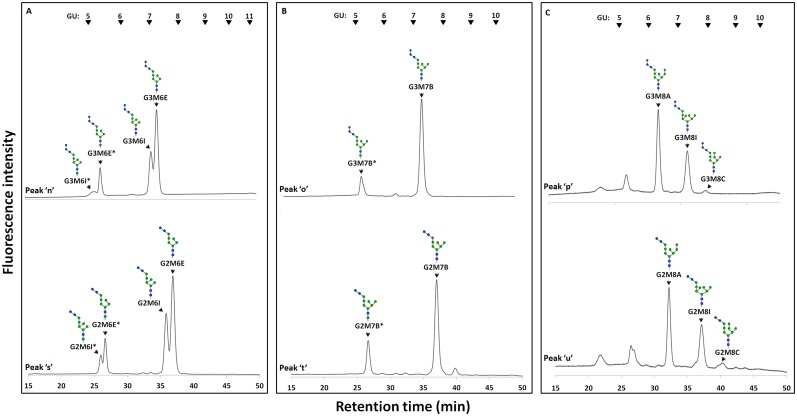
Reversed-phase HPLC profile of tri- and di- glucosylated Man6GlcNAc2 (A), Man7GlcNAc2 (B), and Man8GlcNAc2 (C).The tri- and di- glucosylated FNGs (peaks 'n, o, p' and peaks 's, t, u' respectively) produced in the stationary phase of gls1Δ and gls2Δ cells respectively, were isolated by size fractionation HPLC and structural isomers of each were further separated in reversed-phase HPLC. Asterisks (*) indicate the structures with ManNAc residues at the reducing end which are produced by GlcNAc-to-ManNAc epimerization of the N-acetyl group during PA-labeling reaction. The arrowheads indicate the elution position of PA-glucose oligomer for elution standards.